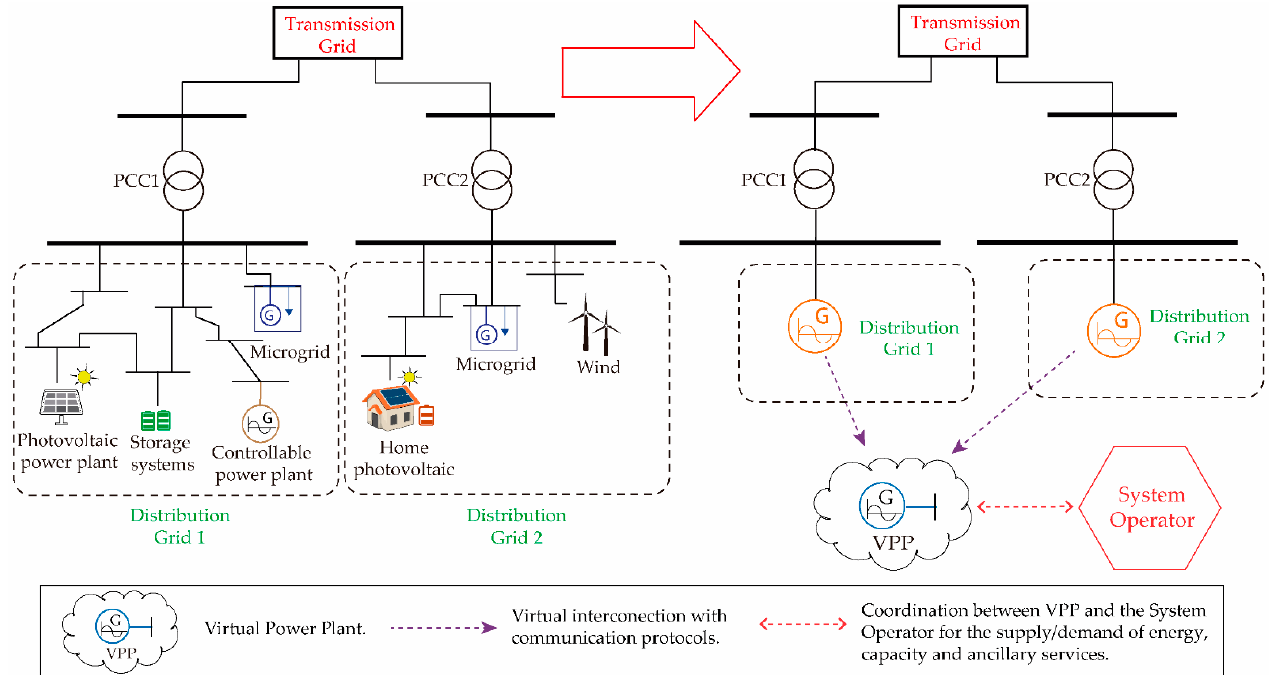
Figure 4. Physical link between the VPP and the distribution grid .